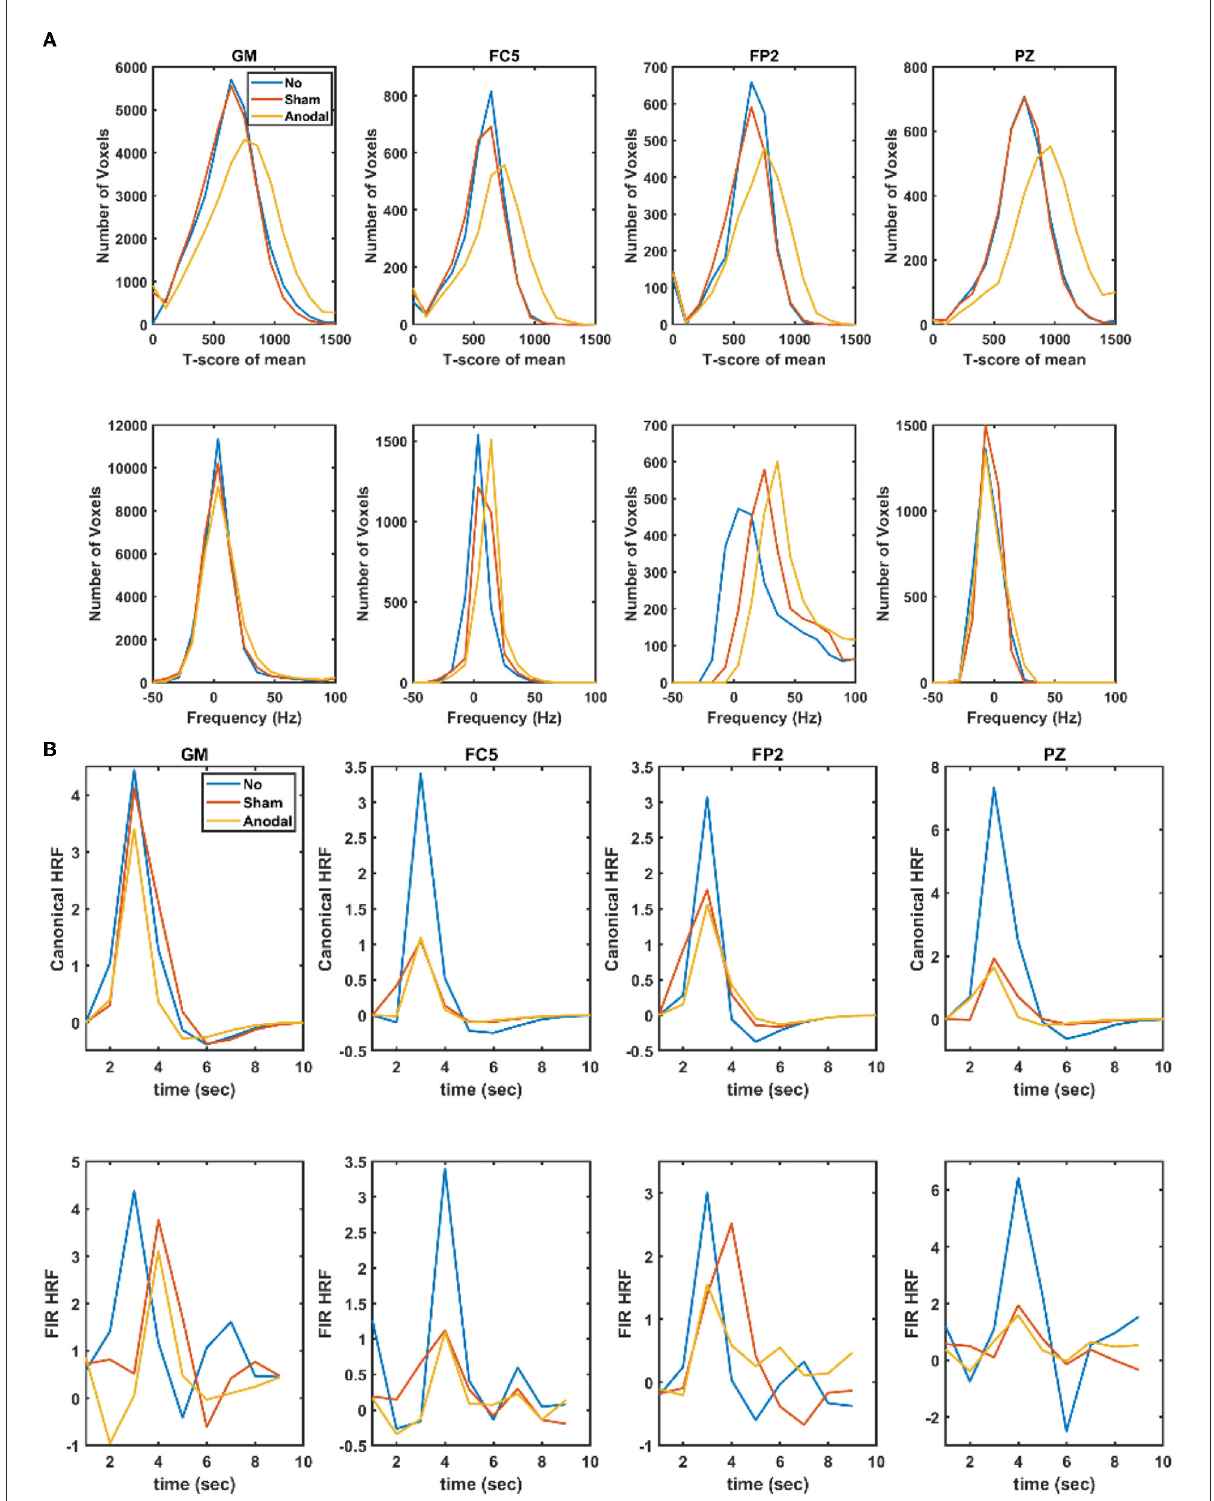
FIGURE1 (A) Functional sensitivity metrics: the top row shows the t -score of the mean in the gray matter (GM) and gray matter ROIs, FC5 (anodal electrode), FP2 (cathodal electrode), and PZ (remote location), while the bottom row shows the corresponding offset frequency (in Hz) to capture field inhomogeneity. (B) Estimated haemodynamic response function (HRF) in the gray matter (GM) and the gray matter ROIs, FC5 (anodal electrode), FP2 (cathodal electrode), and PZ (remote location) where the top row shows the results using canonical HRF with time and dispersion derivatives, while the bottom row shows the results using a finite impulse response model (FIR). No, no-tDCS condition; Sham, sham-tDCS condition; Anodal, anodal-tDCS